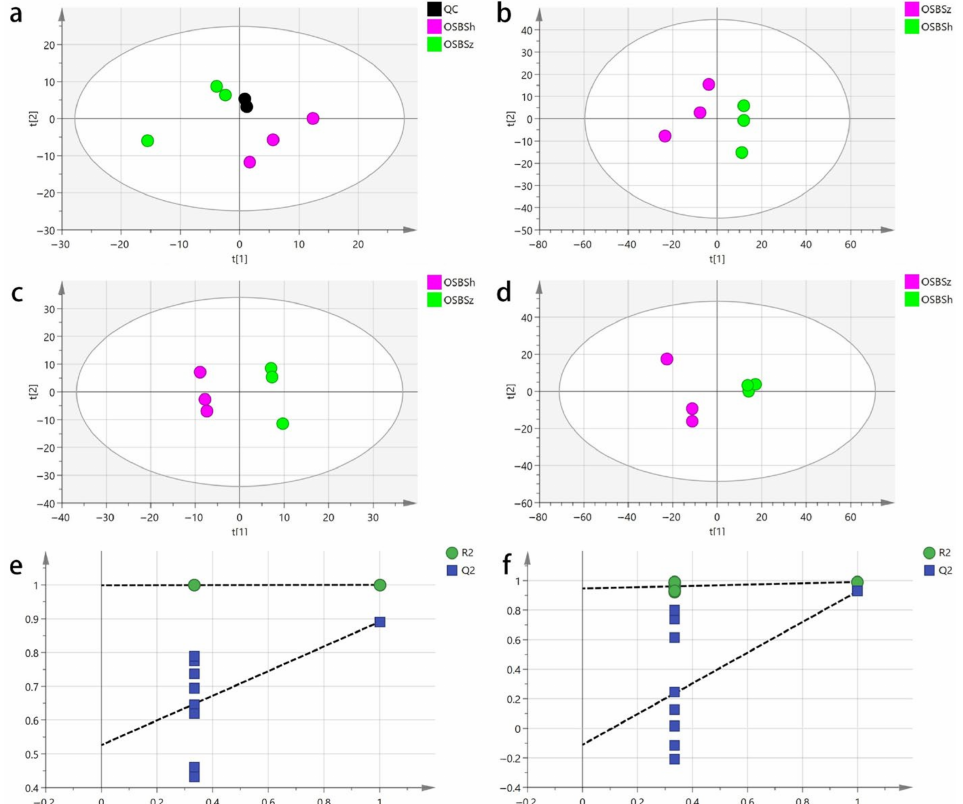
Figure 2. ( a , b ) PCA model score of the widely targeted metabolomics approach ( a ) and the untargeted metabolomics approach ( b ). ( c , d ) PLS-DA model score of the widely targeted metabolomics approach ( c ) and the untargeted metabolomics approach ( d ). ( e , f ) Statistical validation of the PLS-DA model using permutation analysis for the widely targeted metabolomics approach ( e ) and the untargeted metabolomics approach ( f